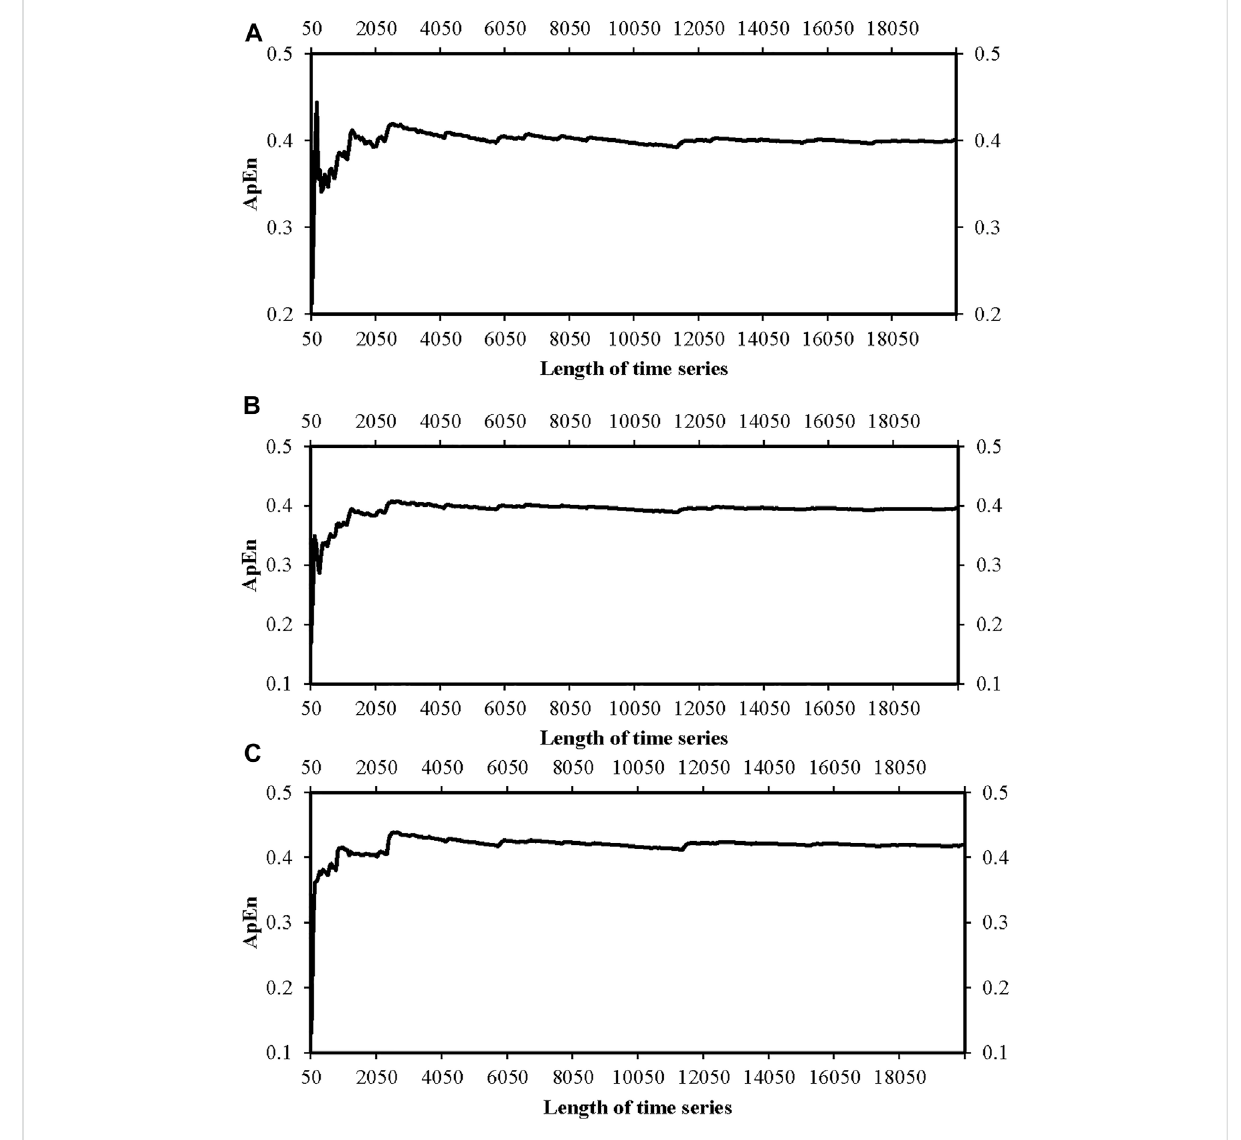
FIGURE 2 ApEn results of the classical Lorenz model with the data length increasing from 50 to 20000 on (A) the variable x, (B) the variable y, and (C) the variable